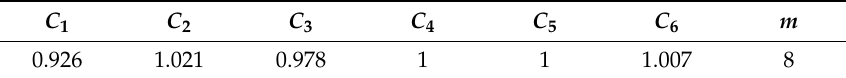
Table 2. Barlat’91 yield function coe ffi cients for AA7075-O